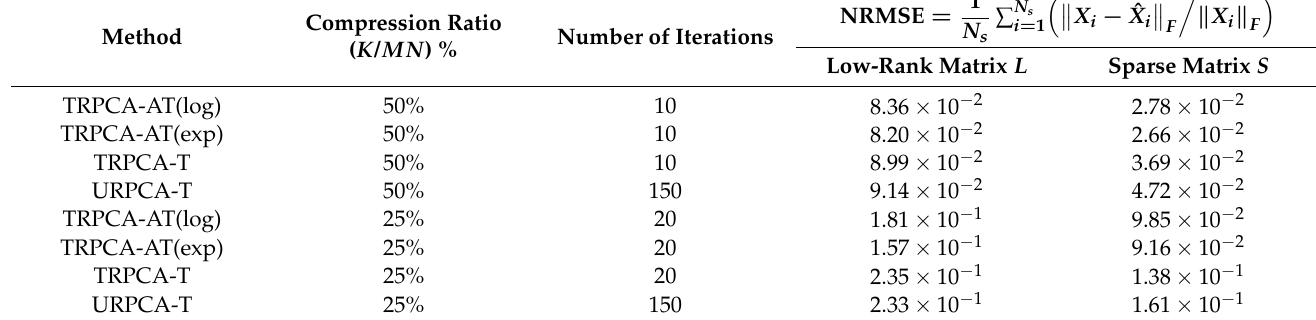
Table 1. Comparison of convergence speeds for ADMM-based trained RPCA with thresholding (TRPCA-T), proposed ADMM-based trained RPCA with adaptive thresholding based on logarithm heuristic (TRPCA-AT(log)), proposed ADMM-based trained RPCA with adaptive thresholding based on exponential heuristic (TRPCA-AT(exp)), and ADMM-based untrained RPCA with thresholding (URPCA-T). The proposed approaches TRPCA-AT(log) and TRPCA-AT(exp) are 15 and 7.5 times faster than URPCA-T for compression ratios 50% and 25%,